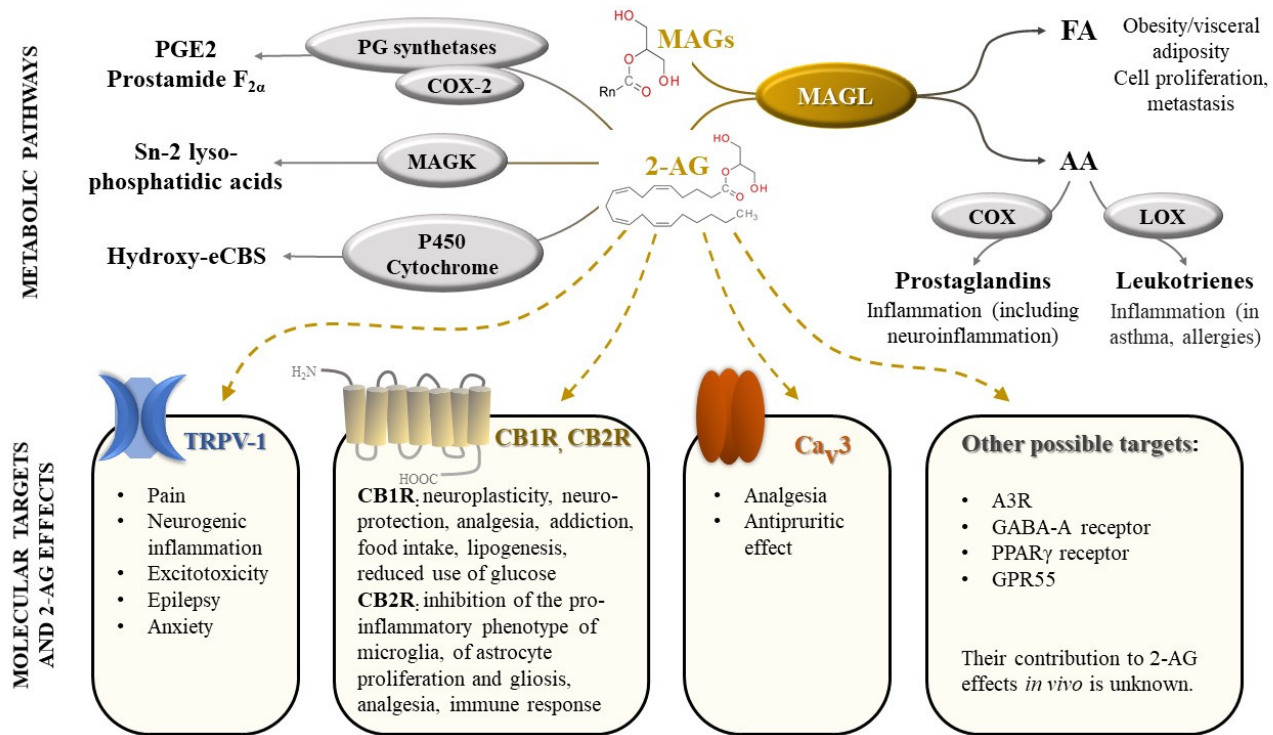
Figure 1. Monoacylglycerol lipase (MAGL), an enzyme with central role in a complex biological network, regulating cannabinoid signaling and arachidonic acid metabolism. Legend: FA-fatty acids; AA-arachidonic acid; COX—cyclooxygenase; LOX—lipoxygenase; MAGs—monoacylglycerols ( n = 8–18); 2-AG—2-arachidonoylglycerol; PG—prostaglandin; PGE2—prostaglandin E2; MAGK—monoacylglycerol kinase; eCBs—endocannabinoids; TRPV-1—transient receptor potential vanilloid type 1; CB1R—cannabinoid receptors 1; CB2R—cannabinoid receptors 2; Ca v 3 T-type calcium channel; A3R—adenosine receptor 3; GABA-A receptors- γ -Aminobutyric acid type A receptors; PPAR- γ receptors—Peroxisome proliferator-activated γ receptors; GPR55—G protein-coupled receptor 55.